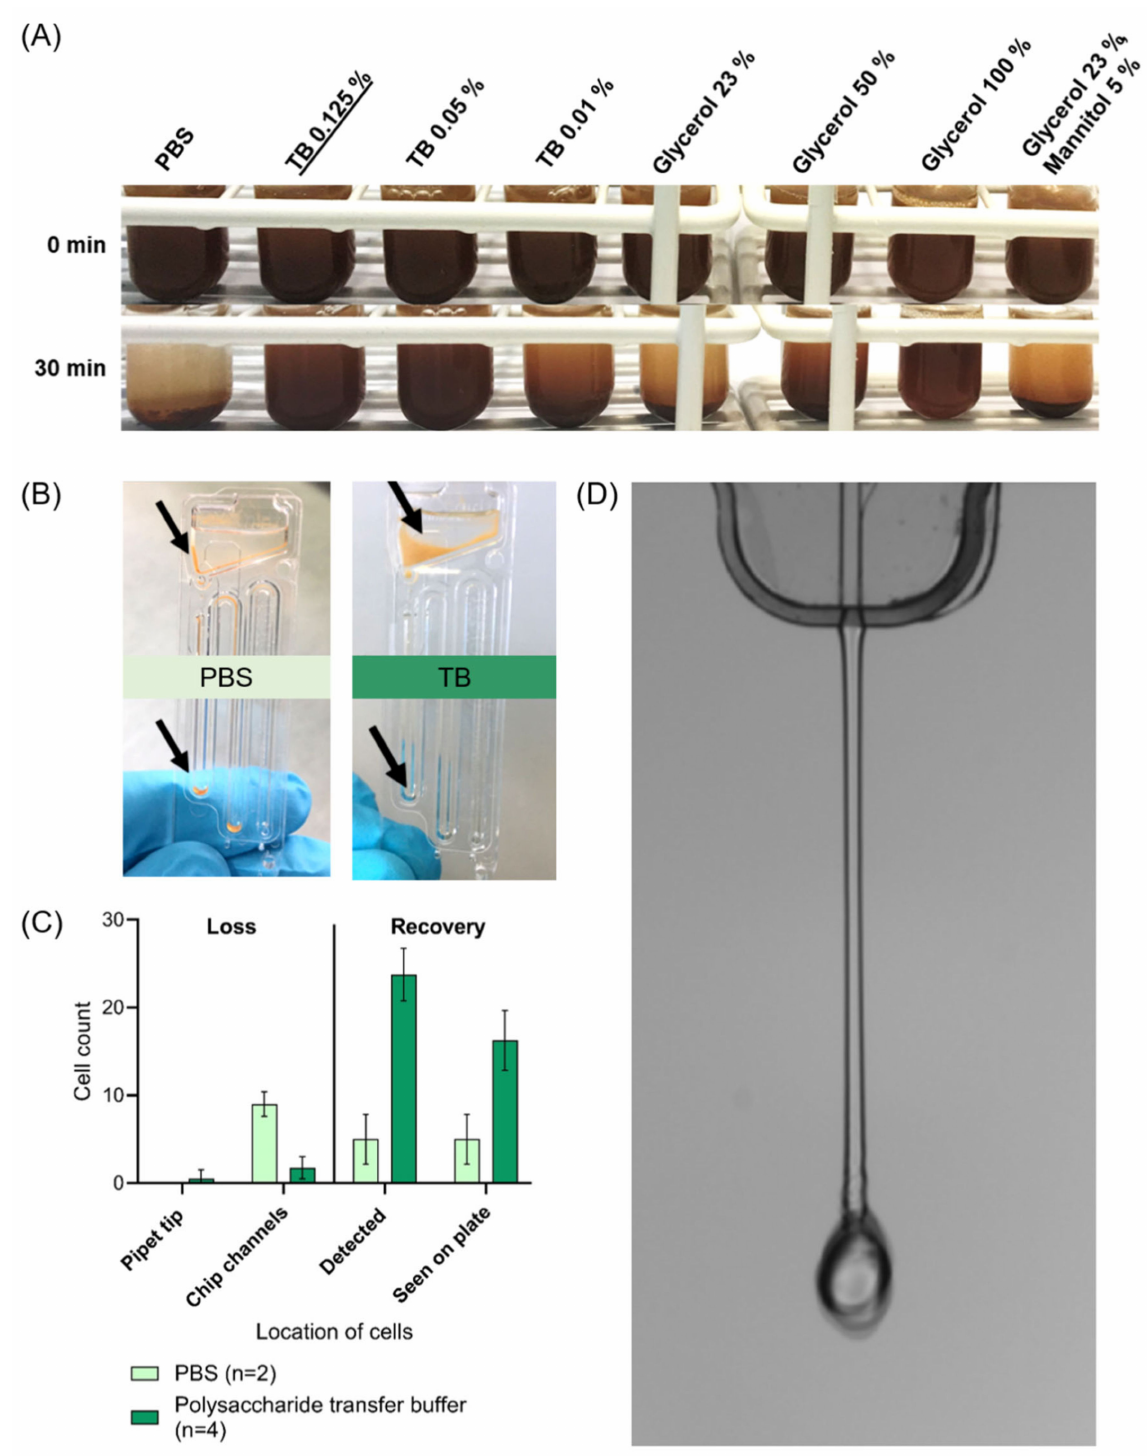
Figure 2. Influence of flow buffer composition on magnetic microbeads in microfluidic systems. ( A ) Bead sedimentation test was performed with 5 × 10 9 /mL 1 µ m beads in different solutions of phosphate buffered saline (PBS), polysaccharide transfer buffer (TB), glycerol and mannitol. The visual sedimentation was documented after 30 min. ( B ) The use of 0.125% TB strongly reduced bead sedimentation in the chip funnel and the meander structures of the microfluidic cartridge compared to PBS which also significantly increased cell recovery ( C ) after automated isolation of MCF-7 cells (5 ± 2.8 vs 16.2 ± 3.4). ( D ) Precise dispensing of a droplet out of the chip